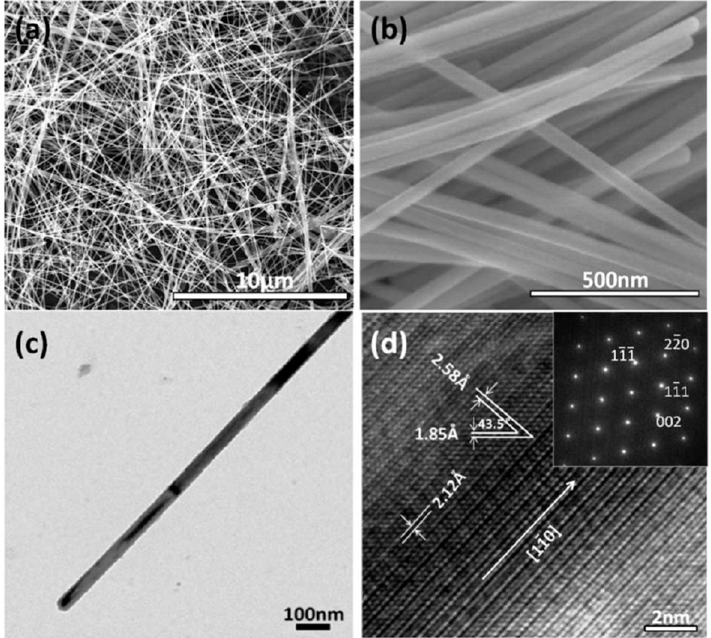
Figure 4. Structural and morphological characterization of Cu nanowires synthesized via a microwave (MW)-assisted method in aqueous solution. ( a ) Scanning electron microscopy (SEM) image; ( b ) magnified SEM image; ( c ) TEM image; and ( d ) high-resolution TEM image. Reproduced with permission from Reference [90].